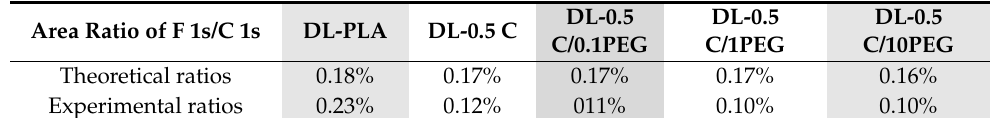
Table 6. Area ratios of F 1s/C